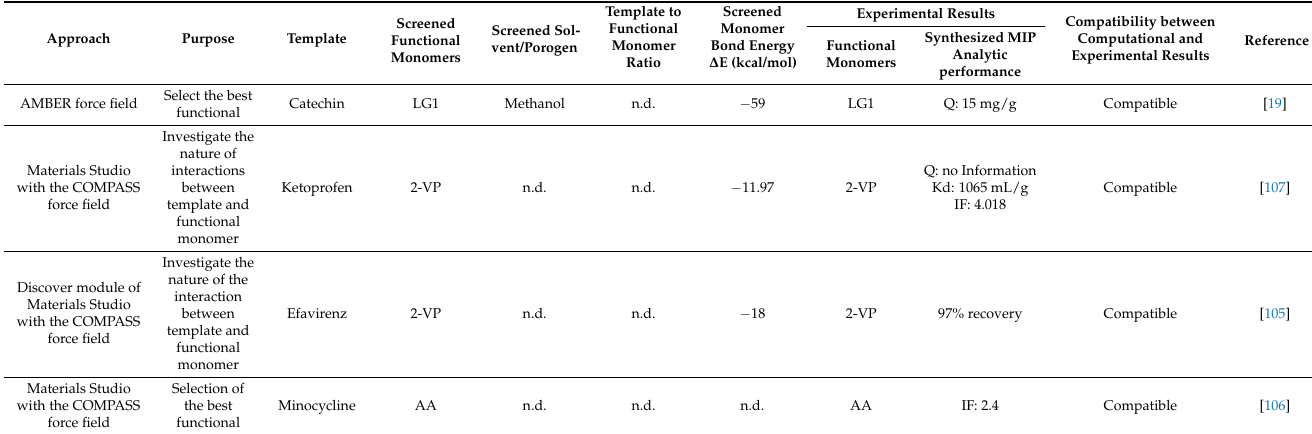
Table 10. Molecularly imprinted polymer (MIP) design using molecular